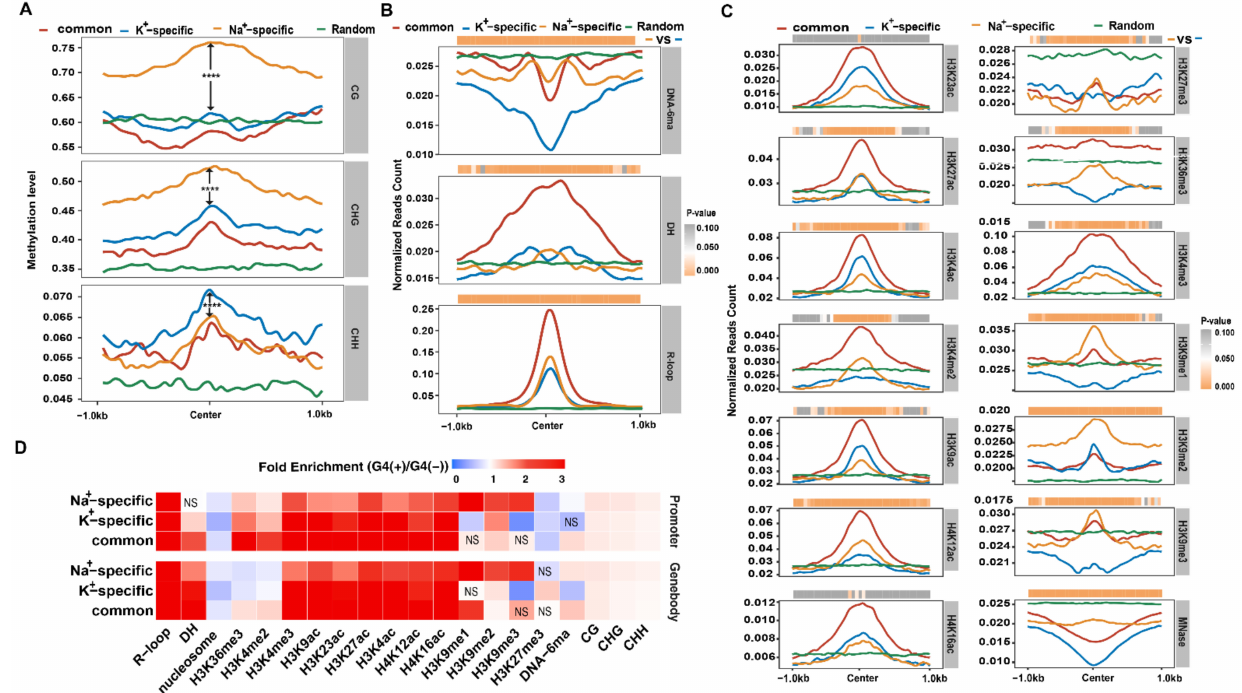
Figure 4. Epigenomic features of K + - and Na + -specific and common IP-G4s. ( A ) CG, CHG, and CHH methylation levels across ± 1 kb of the center of K + -specific, Na+-specific IP-G4s, and common IP-G4s and random control with similar C content. ( B ) Distributions of normalized read counts of DNA-6mA (6mA), DNase-seq (DH), and DRIP-seq (R-loop) across ± 1 kb of the center of K + - and Na + -specific, common IP-G4s, and random control. The heat map at the top indicates the Wilcoxon rank-sum test between K + - and Na + -specific IP-G4s, and the color key represents the p -values. ( C ) Distributions of normalized read counts of ChIP-seq with 13 histone marks and MNase-seq across ± 1 kb of the center of K + - and Na + -specific IP-G4s, common IP-G4s, and random control. The heat map at the top indicates the Wilcoxon rank-sum test between K + - and Na + -specific IP-G4s, and the color key represents the p -values. ( D ) Heat map showing the enrichment levels of each mark for K + - and Na + -specific and common IP-G4s at promoters and gene bodies; the color key represents the fold enrichment of each subtype of IP-G4s relative to IP-G4s-. A chi-squared test was conducted to determine the significance of the differences ( p -value < 0.05). NS represents non-significance. The significance in Figure 4A was determined using the Wilcoxon rank-sum test. **** p -value <